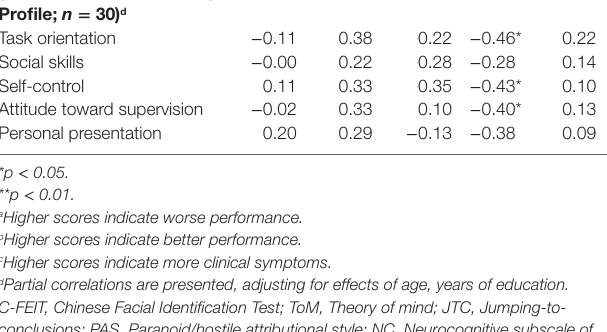
scores than the controls. An unexpected finding was that